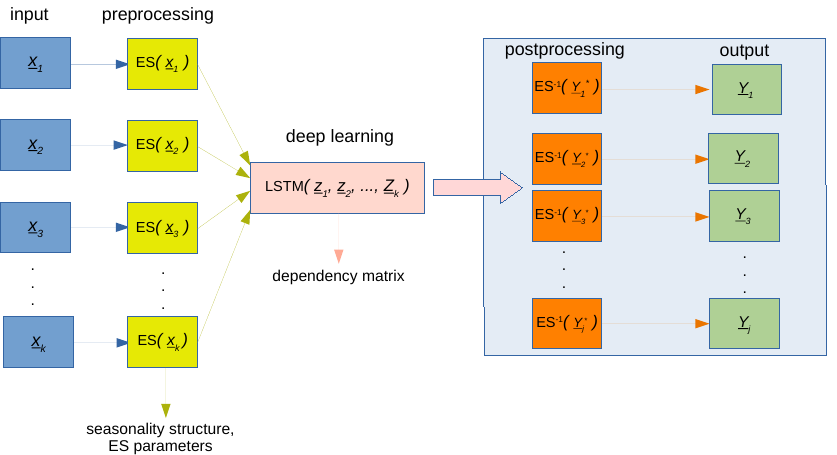
Figure 1. MES-LSTM Data